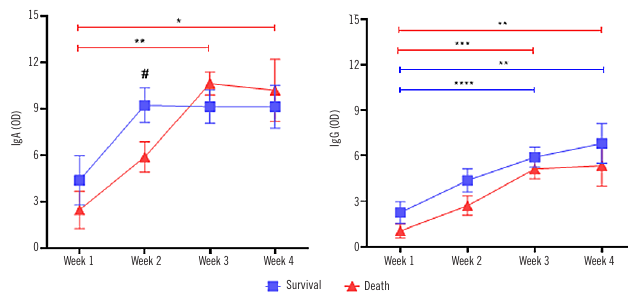
FIGURE 2 – Weekly assessment of IgA and IgG levels according to the outcome (survival vs death). Data are shown as mean ± SEM * p < 0.05; ** p < 0.01; *** p < 0.00; **** p < 0.0001 indicates comparison between timepoints for each group (Kruskal-Wallis test with Dunn's post-test; survival – blue lines vs death – red lines); # p < 0.05 indicates the comparison between survival vs death in at week 2 (Mann-Whitney test).